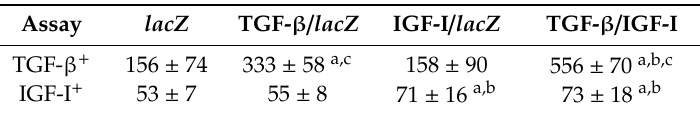
Table 1. Transgene expression in human OCD supernatants following implantation of rAAV-transduced hMSC aggregates (day 21). The levels of TGF- β production are in pg / mL and those of IGF-I in pg / mL. Data are given as mean ± SD. Statistically significant relative to a lac Z, b TGF- β / lac Z, and c IGF-I / lac Z; TGF- β + , TGF- β -positive; IGF-I + , and IGF-positive.